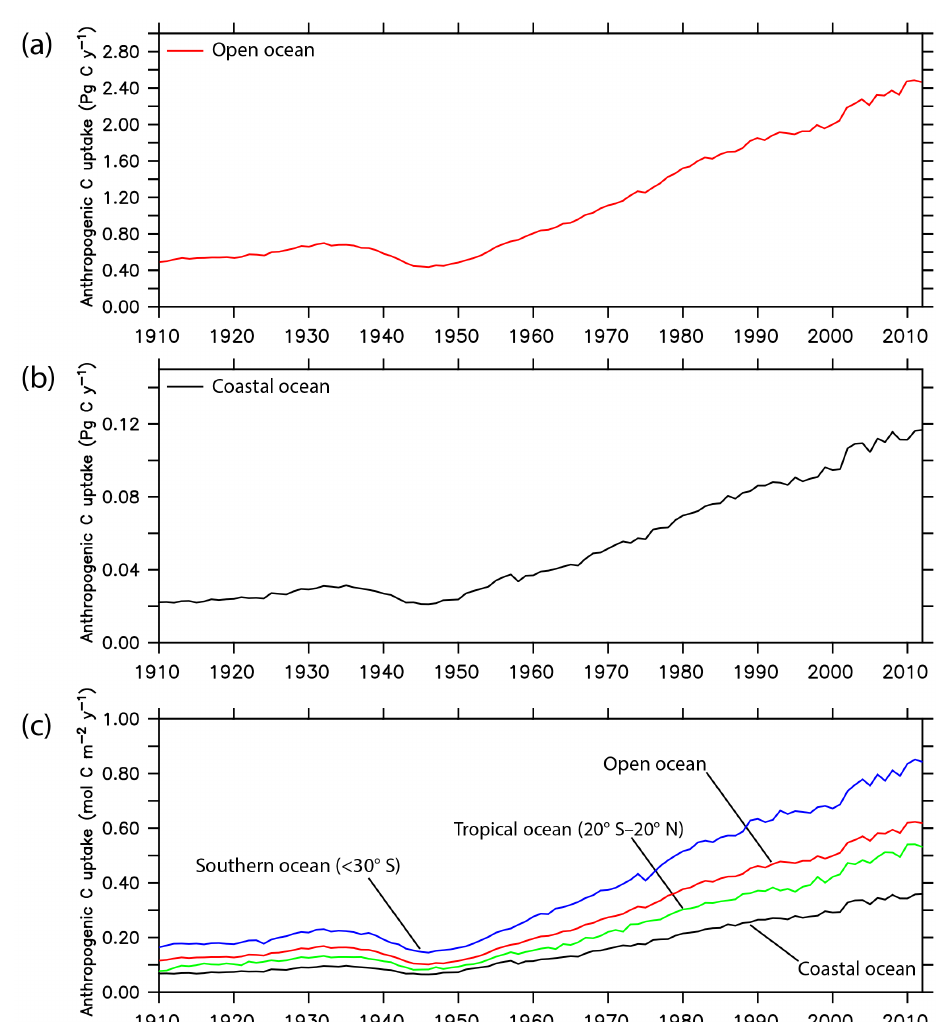
Figure 2. Simulated temporal evolution of area-integrated anthropogenic carbon uptake for (a) the open ocean and (b) the coastal ocean. (c) Analogous evolution of anthropogenic carbon uptake for the open ocean, the coastal ocean, the Southern Ocean, and the tropical oceans, but given as the average flux per unit area. Table 1. Sea-to-air total CO 2 fluxes (PgCyr − 1 ) given as zonal means from Takahashi et al. (2009) for the reference year 2000, from Landschützer et al. (2014) for 1998–2011 and the ORCA05 model for 1993–2012. Latitudinal Observation-based climatologies This study